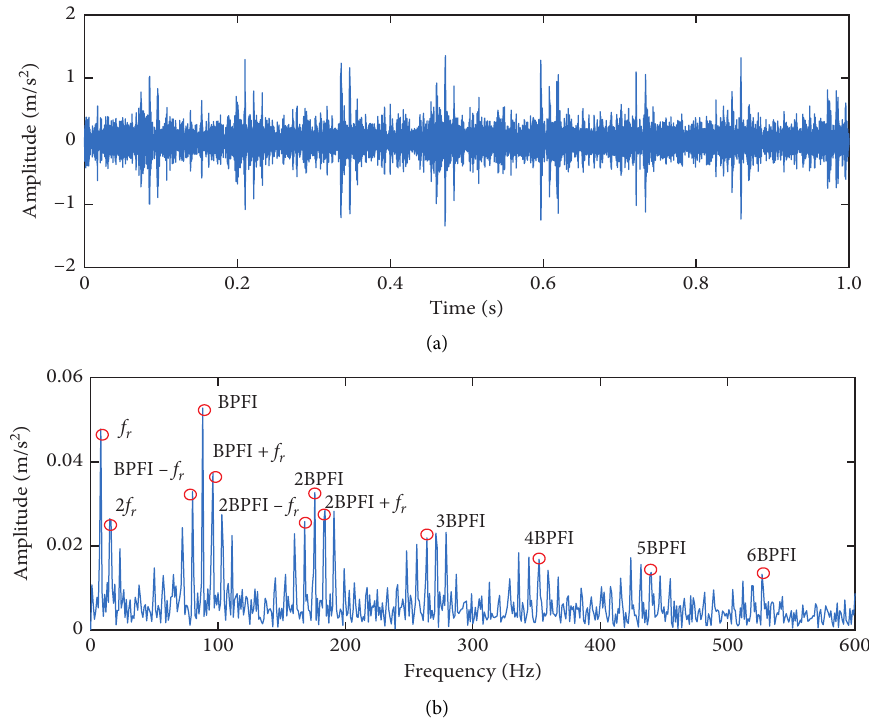
Figure 28: Experimental signals of case 2: (a) the time-domain waveform of u2 and (b) the squared envelope spectrum.